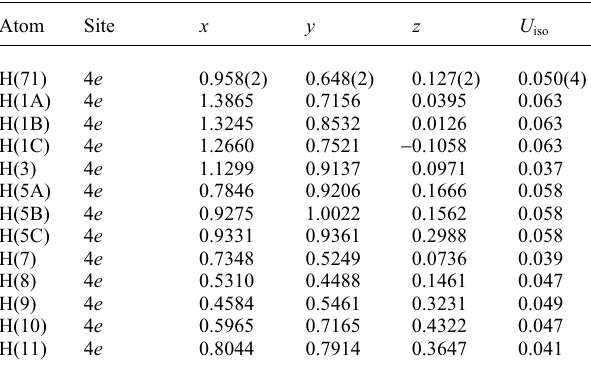
Table 2. Atomic coordinates and displacement parameters (in Å 2 ) .